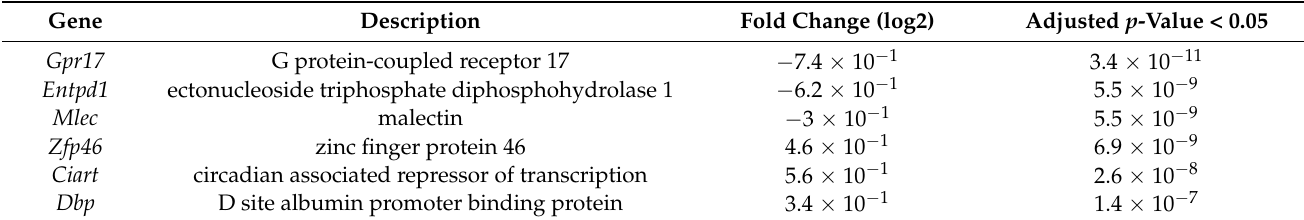
Table 1. Top 3 most significantly down- and upregulated